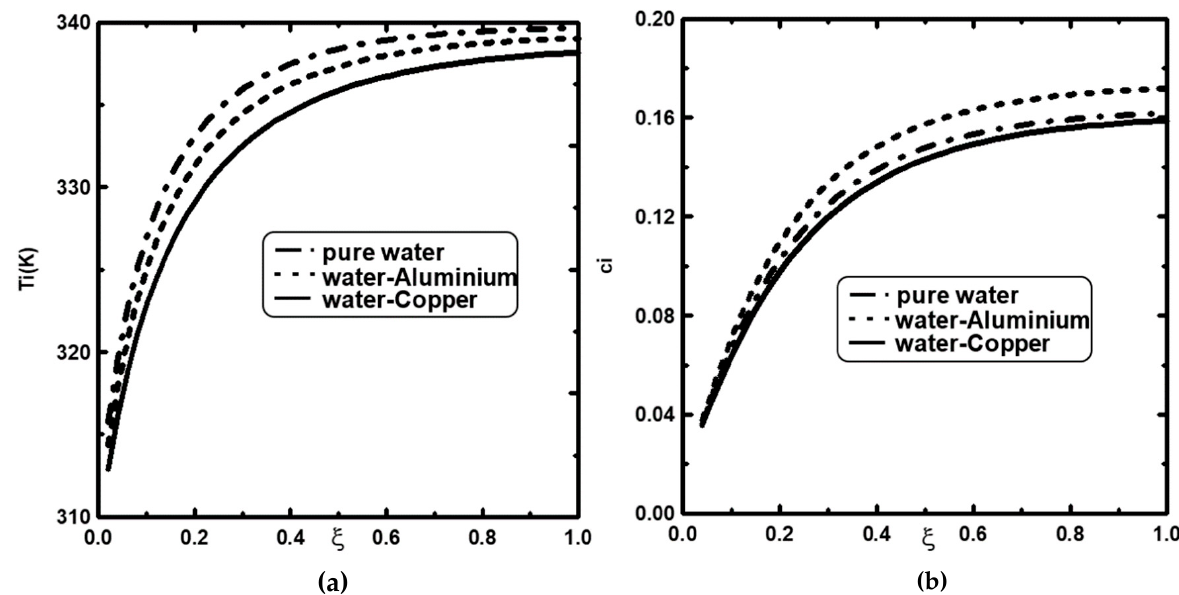
Figure 7. Effect of nanoparticles type on the temperature ( a ) and the vapor concentration ( b ) at the interface liquid-gas: T 0 = 293.15 K, T 0L = 293.15 K, T w = 293.15 K, Φ 0 = 0.03, q 1 = − 1000 W/m 2 , c 0 = 0.3, u 0 = 1 m/s, m 0L = 0.015 kg/m.s, H = 1 m, d = 0.015 m, p 0 = 1 atm.